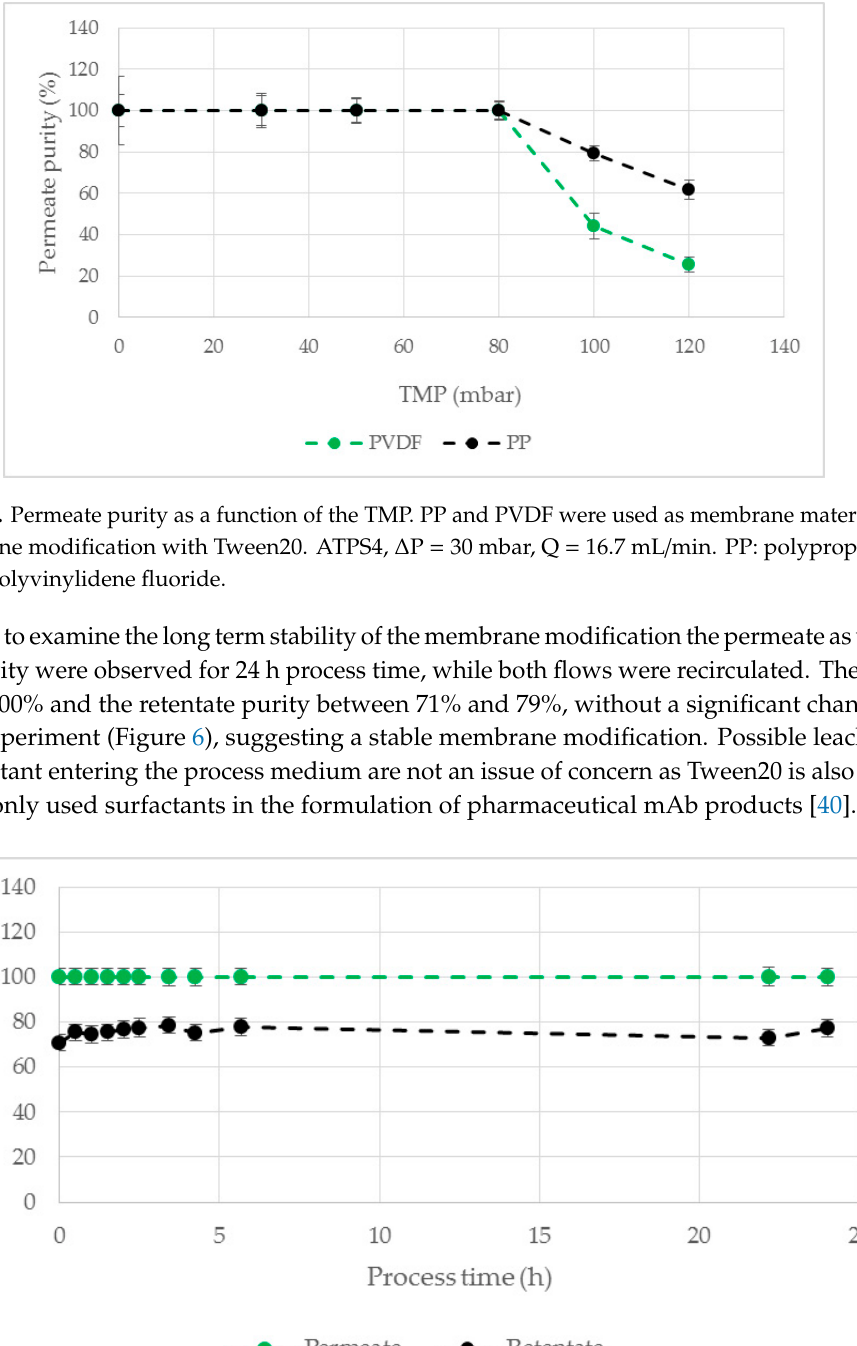
(2) Figure 4. Permeate purity as a function of the TMP. A hydrophobic PP membrane was modified. ATPS4, Δ P = 30 mbar, Q = 16.7 mL/min. PP: polypropylene. The course of the permeate purity as a function of the TMP was investigated (Figure 4). For a TMP value of 0 mbar, a high permeate purity was achieved for all examined surfactants. The membrane with TritonX-114 as modification agent exhibited a strong decrease of the permeate purity